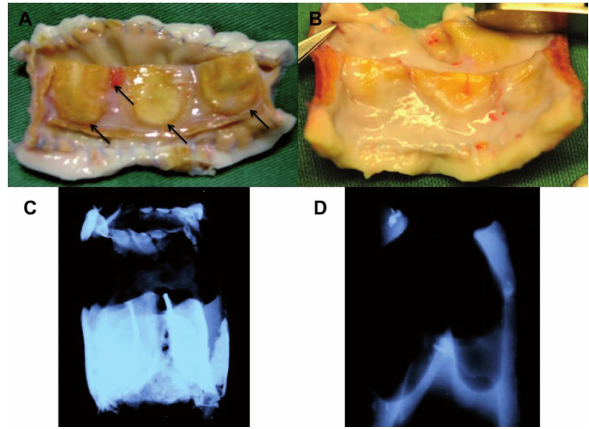
Fig. 1 – Análise macroscópica. Aspecto macroscópico grosseiro e radiográfico dos enxertos. Em A, tubo valvulado GDA com cúspides calcificadas (setas), comprovado pela radiografia, em C, evidenciando a calcificação das cúspides; em B, tubo valvulado DESCEL com cúspides preservadas sem calcificação grosseira, observado em D apenas pontos de calcificação nas linhas de